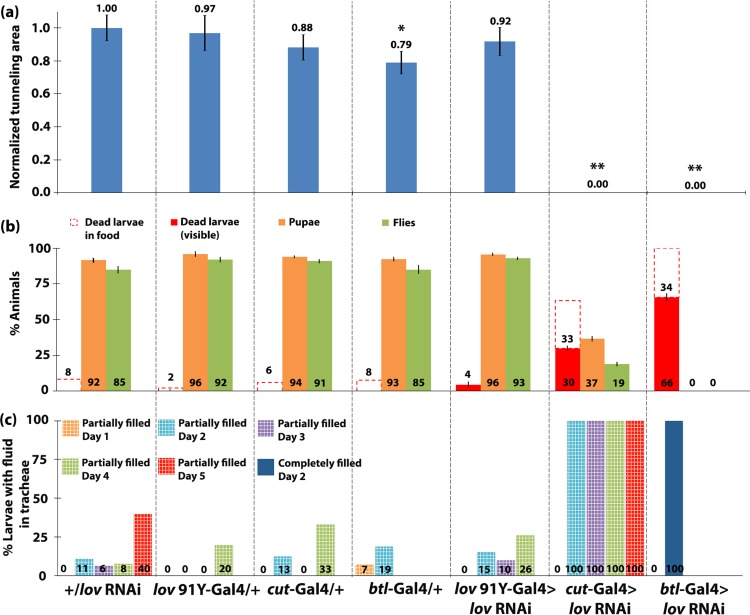
Failure to burrow, tunnel and survive to adulthood correlate strongly with fluid accumulation in the tracheae.(a) Quantitation of tunneling was performed as described in Material and Methods for the genotypes shown. Mean values ± SEMs for the tunneling areas were calculated and then normalized to the value for the +/lov RNAi control. P values, Student’s t-test, * = P< 0.01, ** = P<0.00001, compared to +/ lov RNAi control. b) For larvae subjected to the burrowing/tunneling assay, the average percentage that died in the food, or outside the food (an indication of failure to burrow) was determined, in addition to the average percentage that pupated and the average percentage that emerged as adults. (c) Larvae of the same genotypes as those used for burrowing/tunneling assays, were imaged daily and the images were used to assess accumulation of fluid in the DTs (see Material and Methods). The percentages of larvae with partially fluid-filled DTs (checkered bars) or completely fluid-filled DTs (solid bars) on days 0–5 post-hatching are shown.